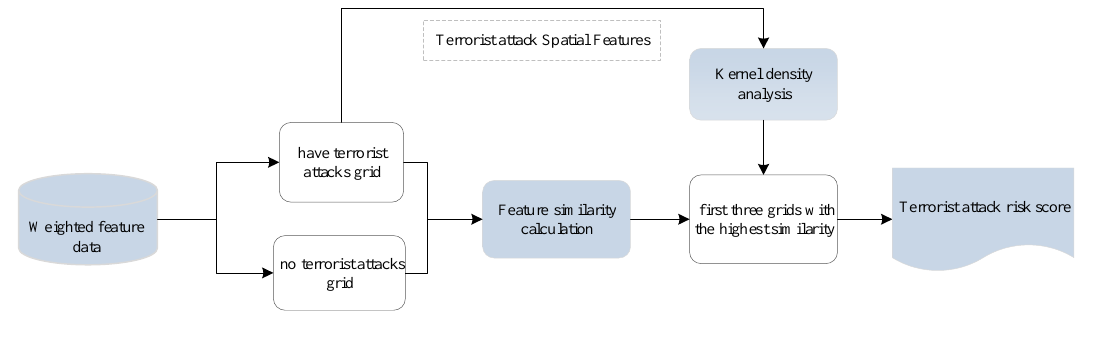
Figure 4. Calculation flow chart.